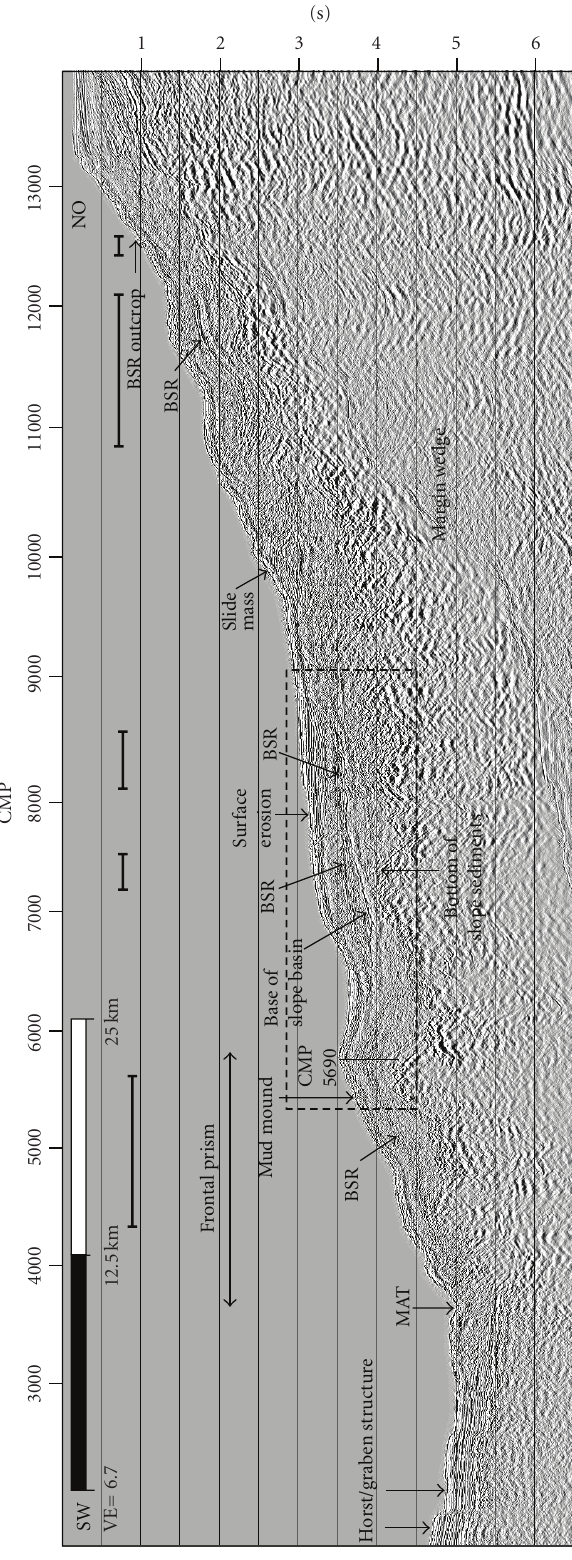
Figure 3: Seismic profile BGR99-46. A BSR is patchy distributed (black bars) from the Middle American Trench (MAT) to its outcrop at ∼ 600 mbsl. The oceanic crust is characterized by a horst and graben structure. The margin wedge is strongly disrupted. The large slide mass, the surface erosion, and the mud mound are also marked on the bathymetry shown in Figure 2. The dashed box is the close-up shown in Figure